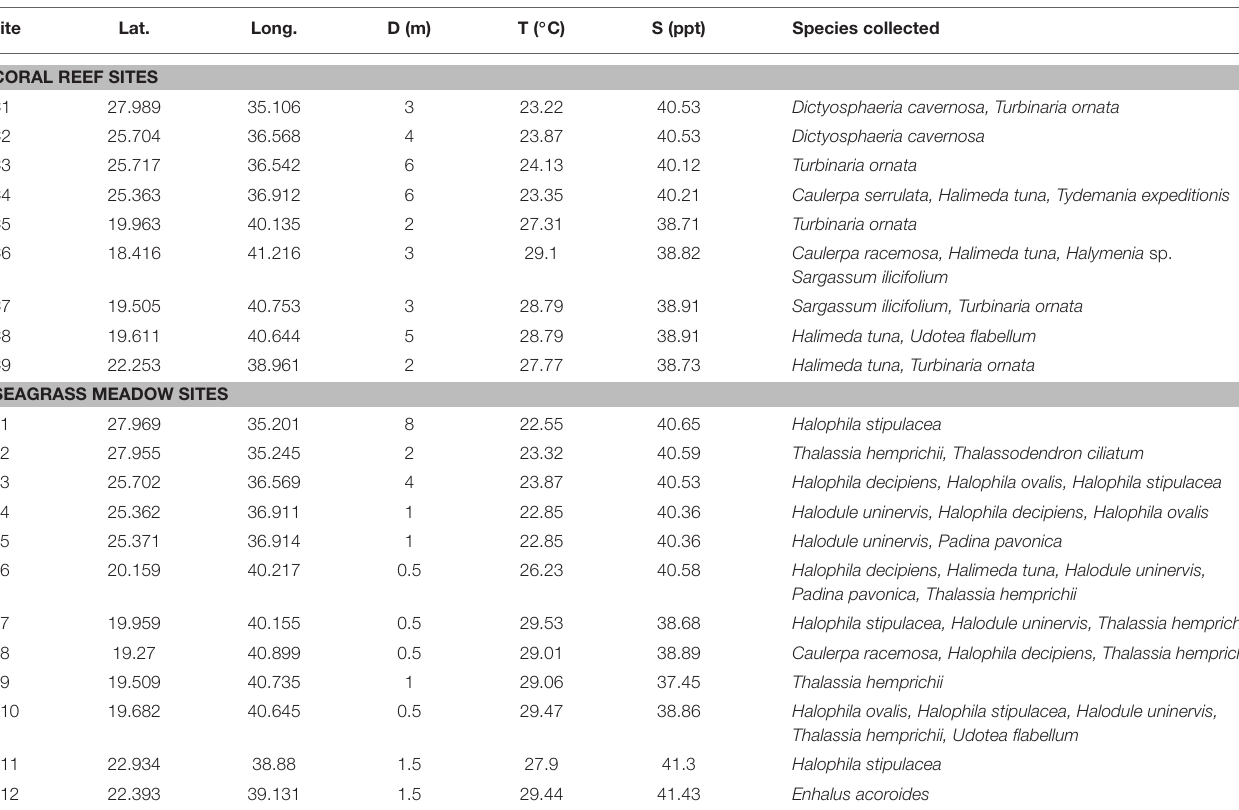
TABLE 1 | Study site information and the species surveyed on each site. Site